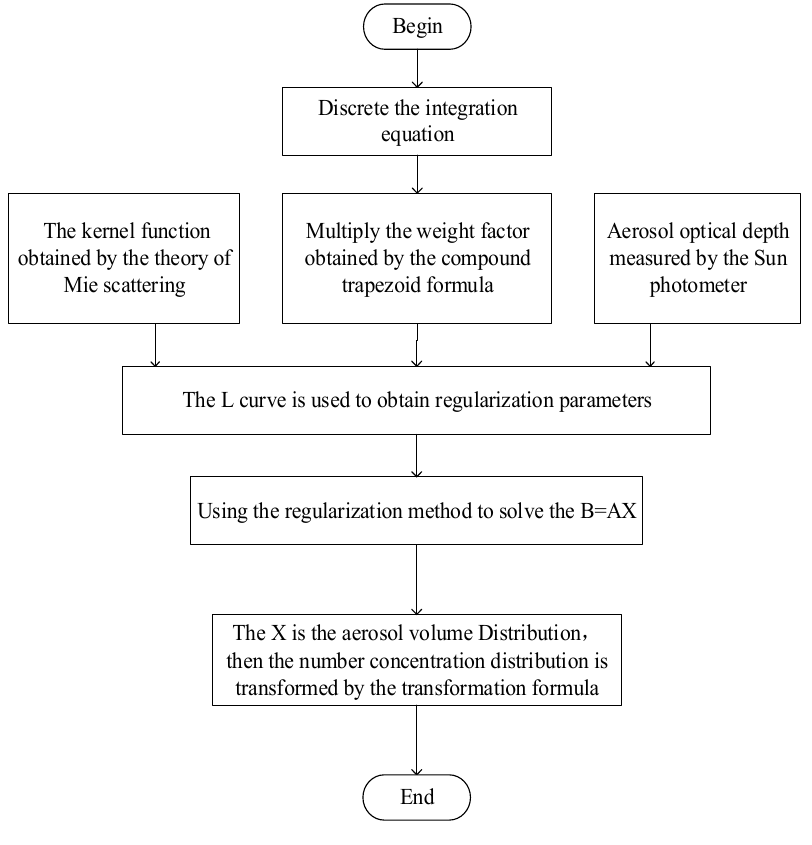
Figure 1. The inversion flow chart of aerosol PSD.